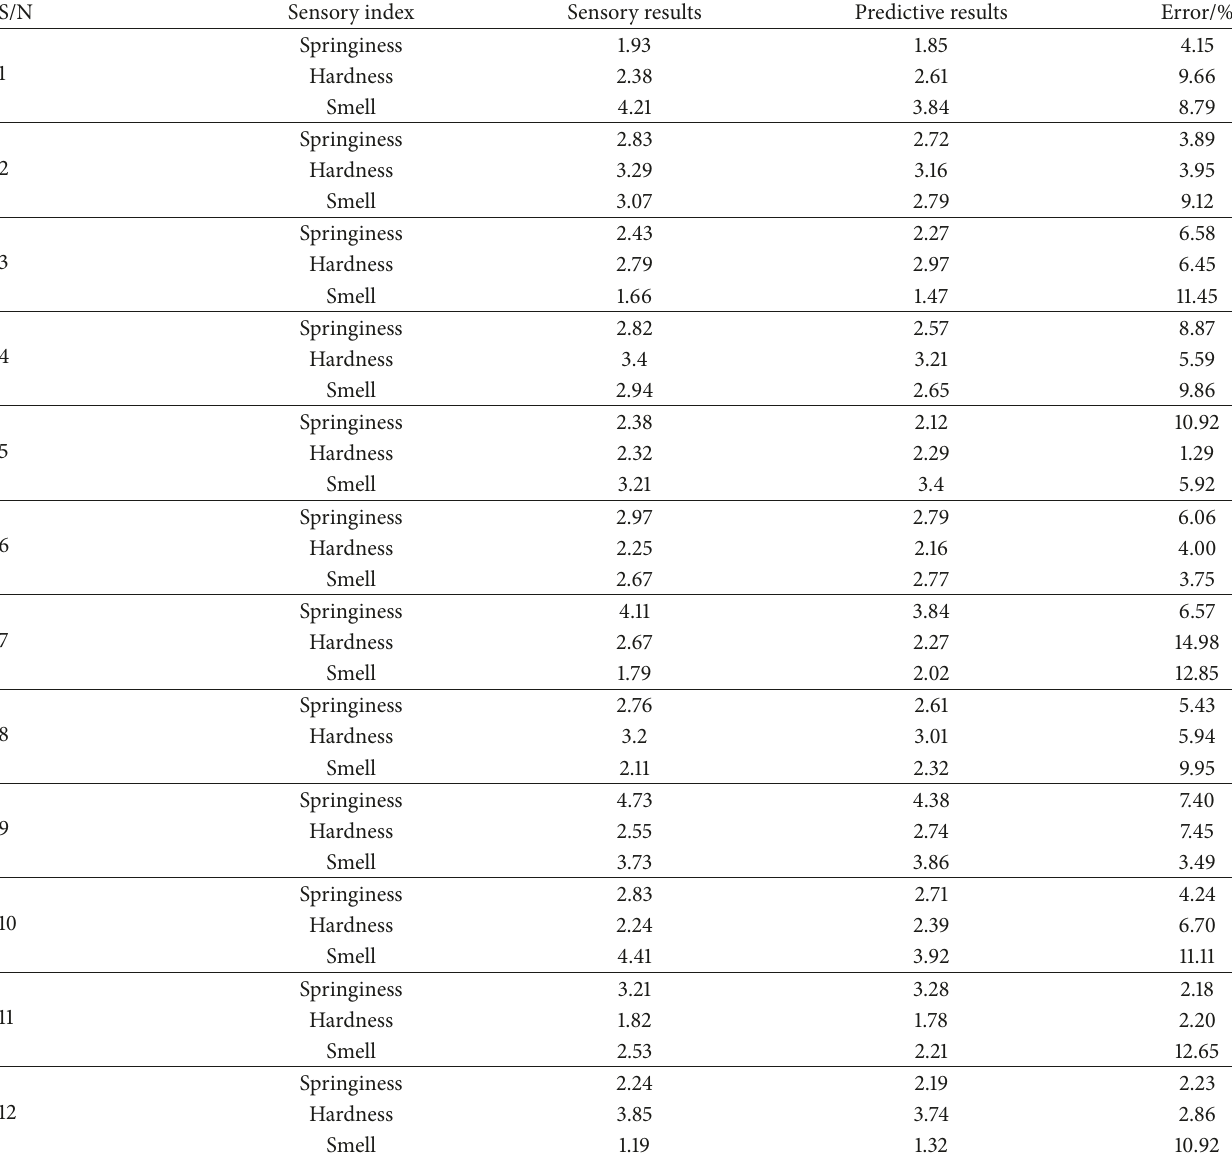
Table 7: Comparison of BP neural network model predictions with actual